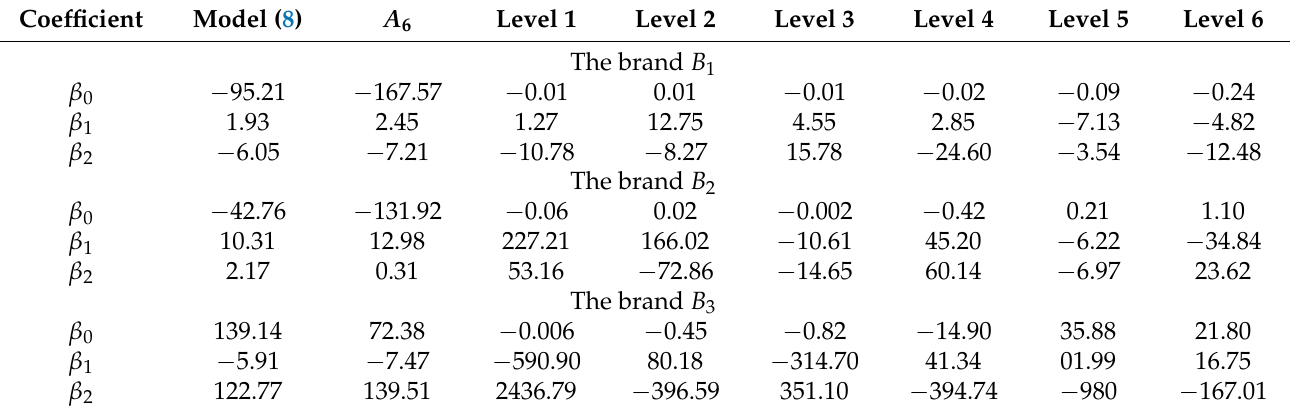
Table 5. Model (9) coefficient estimations for brands B i , 1 ≤ i ≤ 6, at different